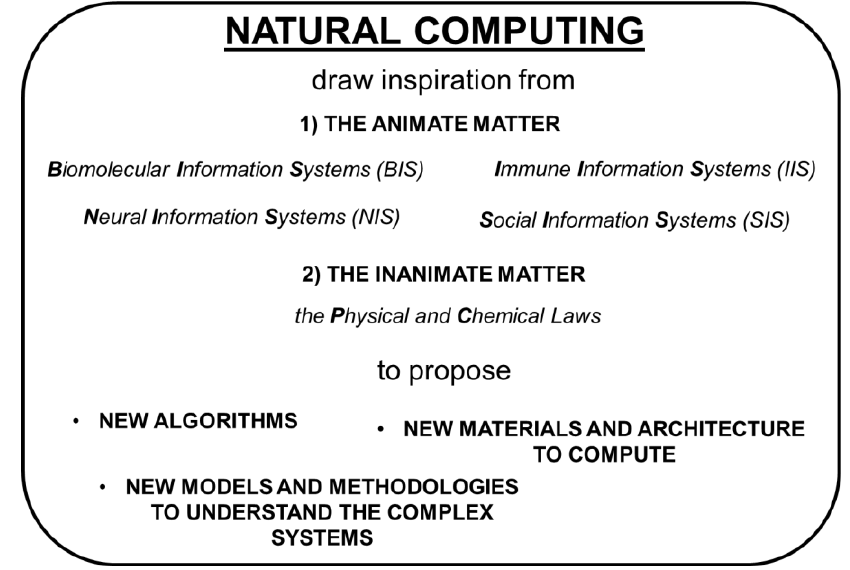
Figure 1. The contribution of the natural computing in coping with the challenges of the computational and natural complexity.